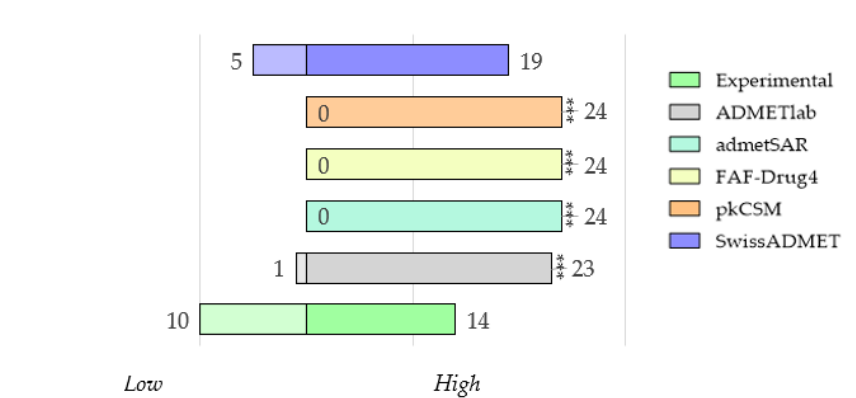
Figure 6. Comparison of experimental and predicted data for human intestinal absorption (HIA), categorized as high and low, between ADMETlab, admetSAR, FAF-Drug4, pkCSM, and SwissADME. Statistical analysis was performed by a pairwise t -test ( n = 24, * p ≤ 0.05, ** p ≤ 0.01, *** p ≤ 0.001, and **** p ≤ 0.0001) versus experimental data.